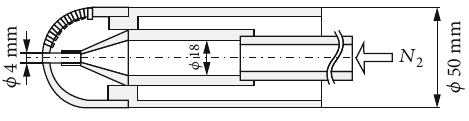
Figure 2: Experimental model.